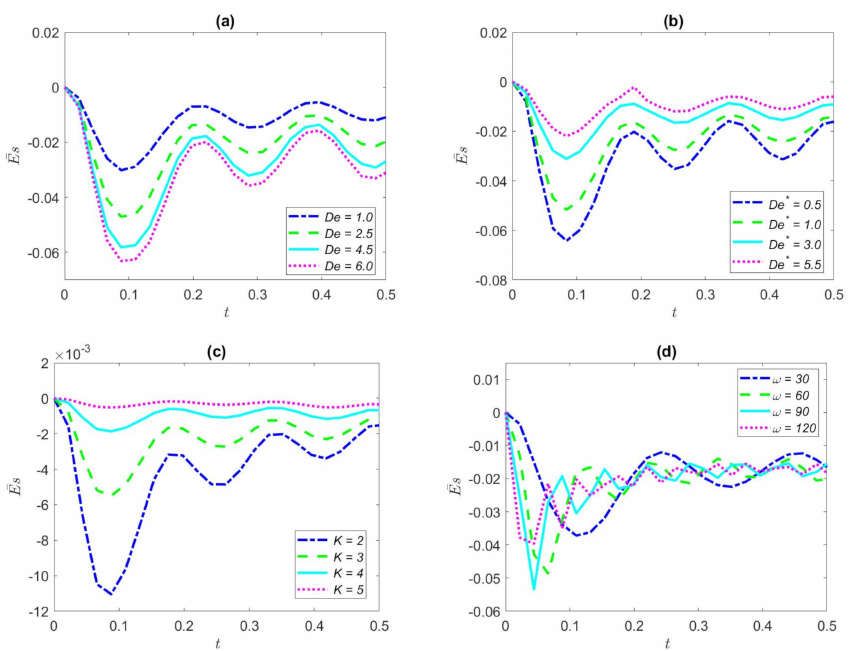
Figure 6. Effects of the dimensionless streaming potential of the cosine waveform for some values of De , De *, K , ω . ( a ) De * = 0.5, ϕ = 2%, ω = 35, Ha = 2, K = 3; ( b ) De = 5.6, ϕ = 2%, ω = 40, Ha = 2, K = 3; ( c ) De = 3, De * = 0.5, ϕ = 2%, ω = 40, Ha = 2; ( d ) De = 1.5, De * = 0.5, ϕ = 2%, Ha = 1, K =